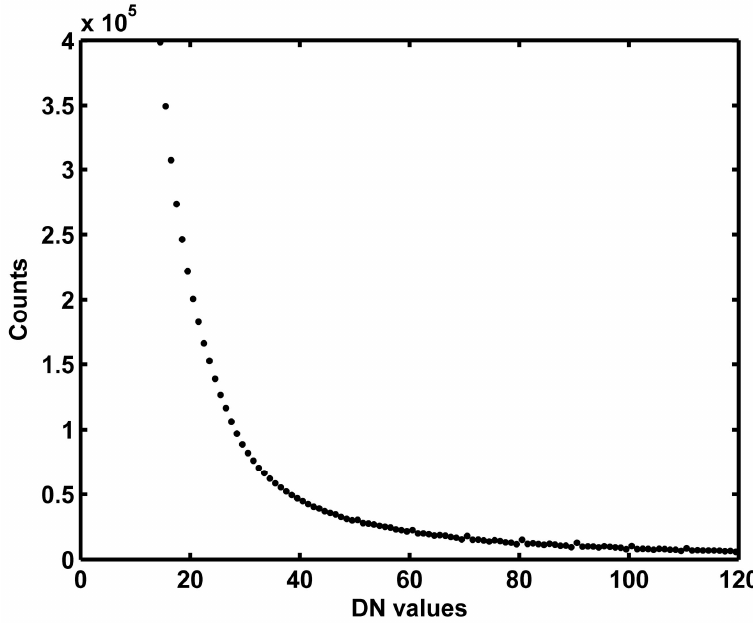
Figure 3. Distribution rule of DN values of the 2006 RCNL image (dots for DN < 15 and DN > 120 have been omitted in the figure to better show the shape of the curve when the DN is close to 63).